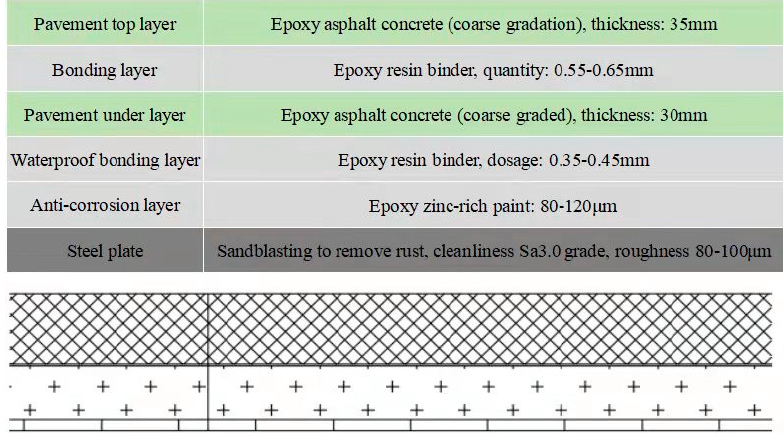
Figure 3. Structural drawing of the steel pavement layer of the steel bridge deck. 2. Traffic Volume.